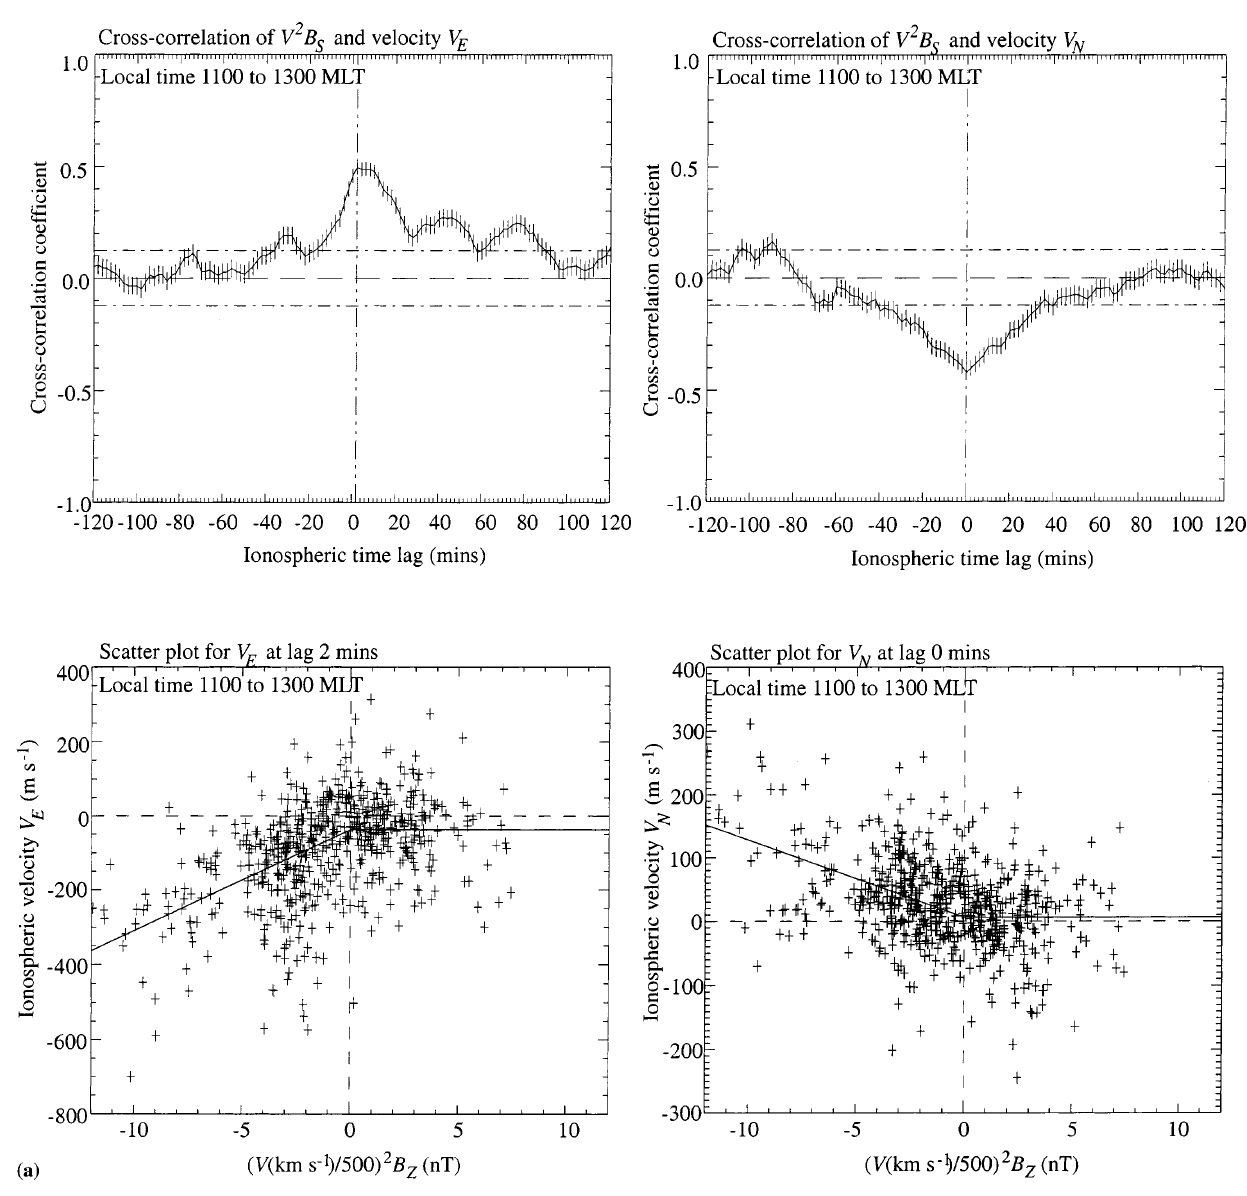
99.9% significance level calculated by the Student’s t -test. The vertical and s dot-dashed line marks the peak in the cross-correlogram. The lower panels provide a corresponding scatter plot of the flow component versus ( V (km s ) 1 )/500) 2 B in nT, plotted at the lag of the peak z correlation coe(cid:129)cient shown in the plot above. A linear least-squares fit of the ionospheric velocity data to the function V 2 B is indicated by s the solid